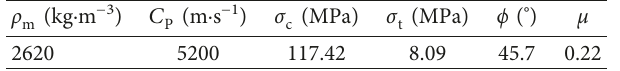
Table 1: Physical and mechanical properties of the rock.